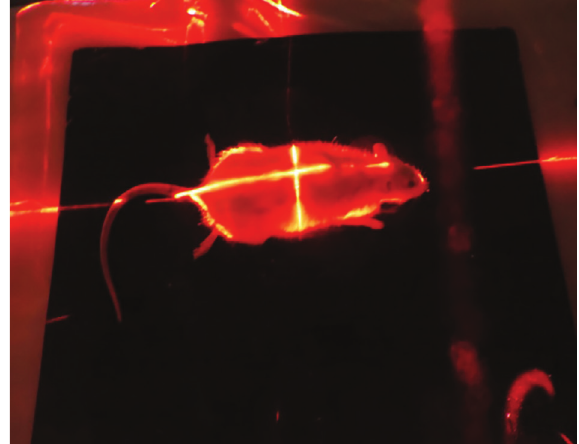
FIGURE 1 - Rat total body 3D dose plan a.